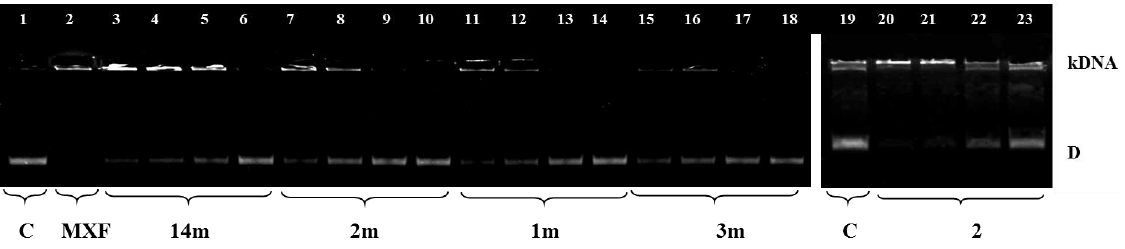
Figure 2. Electrophoretic analysis of S. aureus topoisomerase IV decatenation assay showing catenated kDNA and the decatenated mini circles (D) bands at concentrations of 64, 32, 8, and 0.5 µ g/mL of tested conjugates 2, 1m – 3m , and 14m .